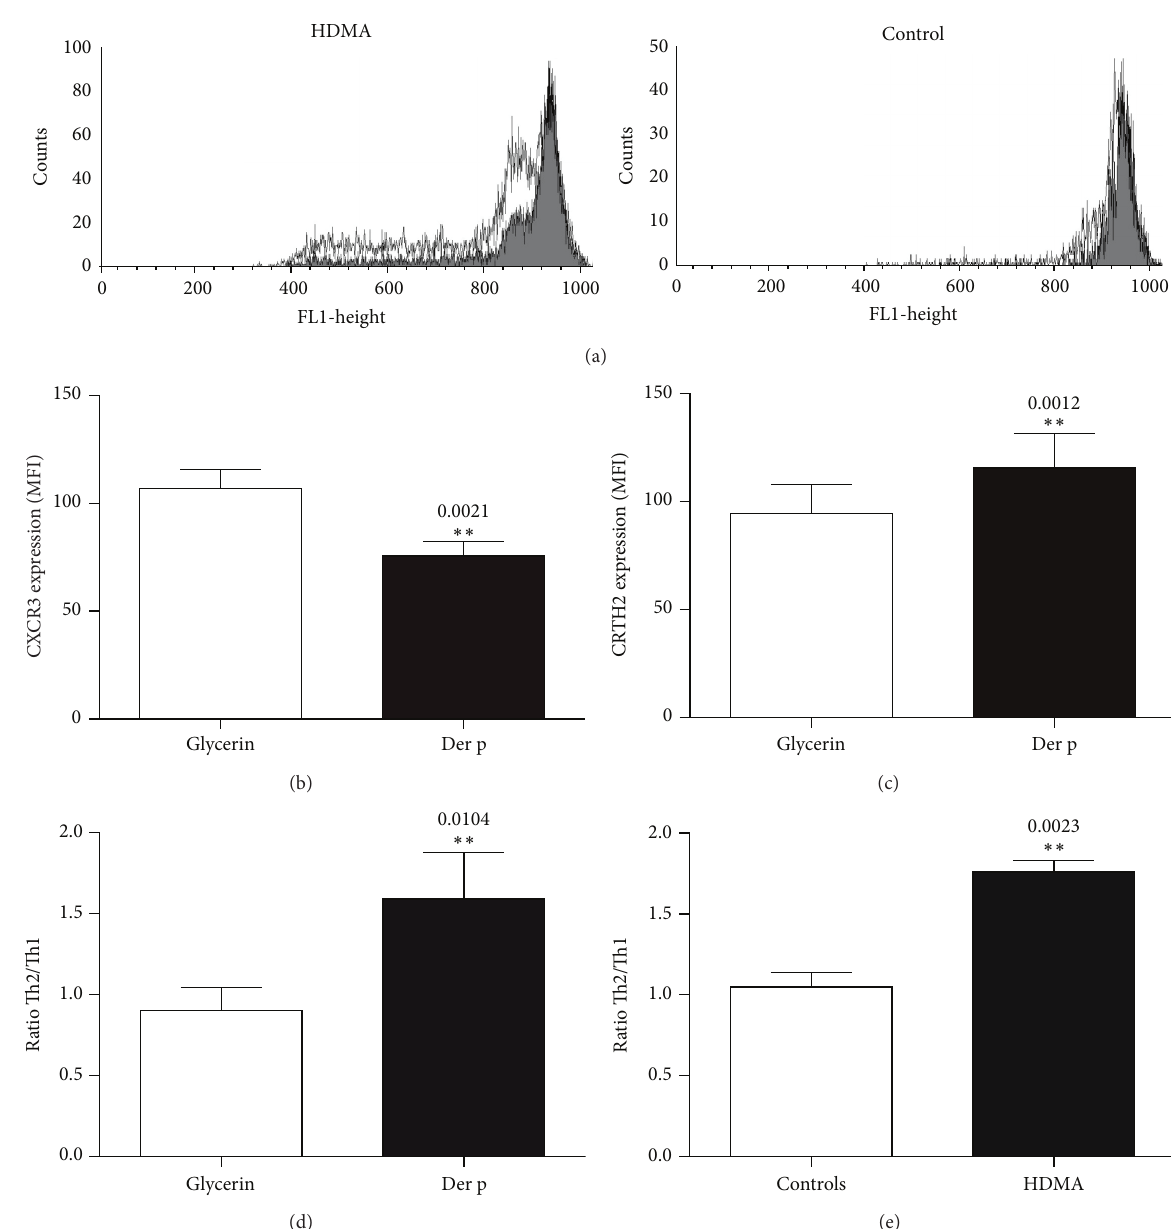
Figure 2: Flow-cytometric analysis of T cell proliferation and Th cell polarization. CFSE-labeled CD4 + T cells from HDM-allergic or HDM- nonallergic individuals were cultured with Der p or glycerin as described in Section 2. T cell division was analyzed by flow cytometry and illustrated as a CFSE division profile (a). Dead cells were excluded based on their light scattering properties. Nondividing CD4 + T cells in the absence of allergen are shown as dark grey histograms. CD4 + T cells that have divided in response to Der p are shown in light grey histograms, based on CFSE dilution peaks. One representative experiment of three is illustrated. In vitro polarization of human Th1 and Th2 precursors following 11 days of culture with glycerin or Der p was determined by flow cytometry using Alexa-conjugated Abs for human CXCR3 (b) or CRTH2 (c), respectively. Data are expressed as geometric mean ( ± SEM) fluorescence intensity (MFI). 𝑃 values are indicated. HDMA = house dust mite-allergic donors. Th2/Th1 ratio of CD4 + T cells from HDM-allergic donors following 11 days of culture with glycerin or Der p (d), 𝑛 = 6 ; Th2/Th1 ratio of Der p-stimulated CD4 + T cells from nonallergic and HDM-allergic individuals (e), 𝑛 = 6 for controls; 𝑛 = 10 for